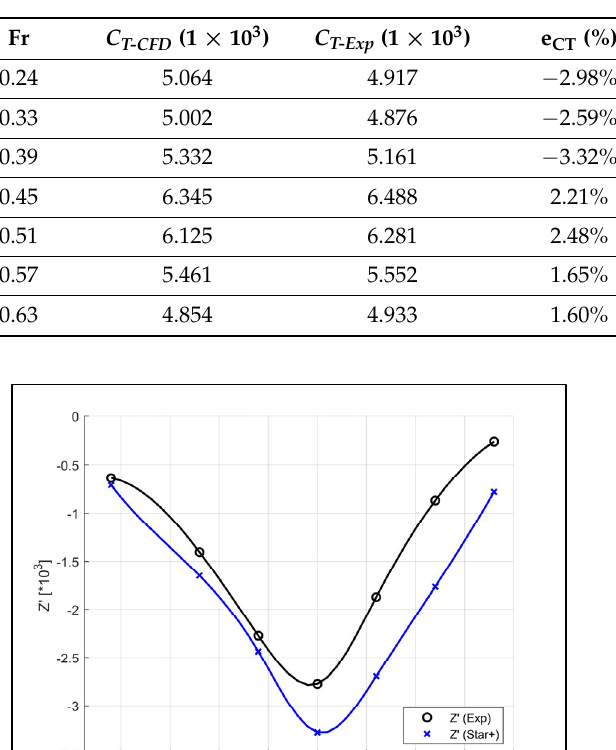
Table 5. Resistance comparison for LC1.